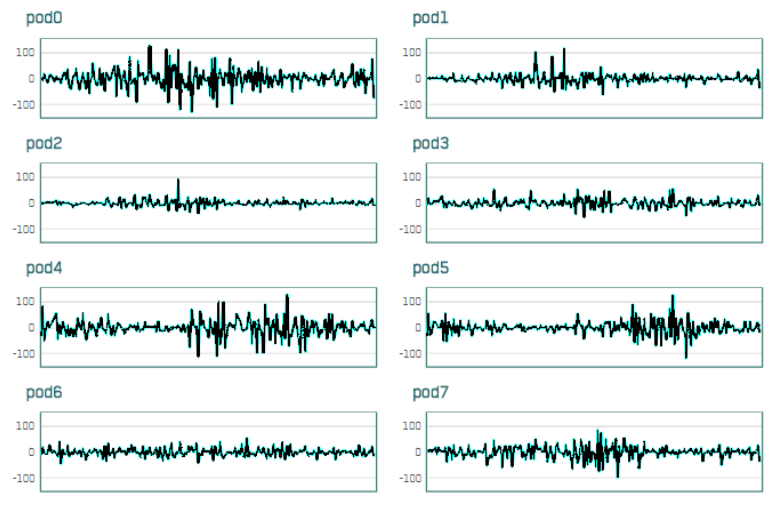
Figure 4. Raw signals (eight) captured with by Myo armband device.